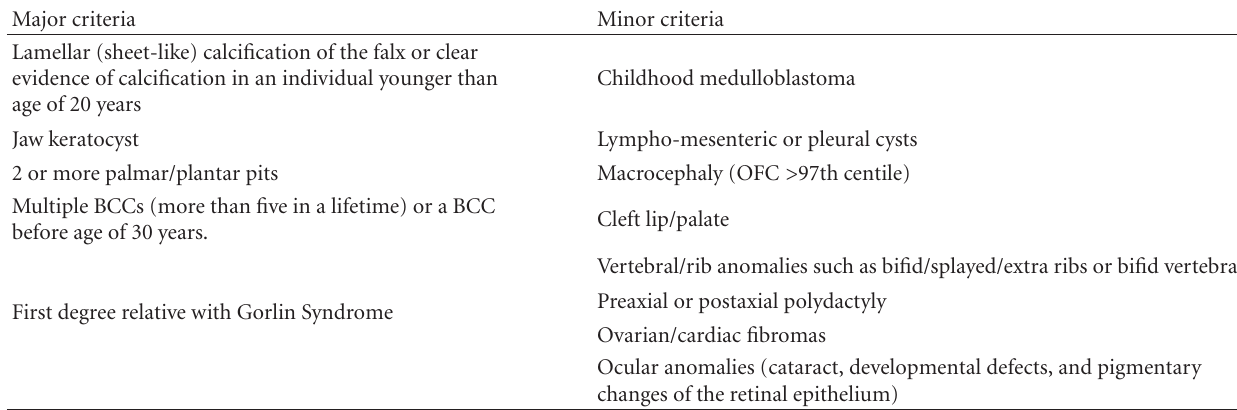
Table 1: Diagnostic criteria for Gorlin Syndrome. A diagnosis can be made when 2 major or 1 major and 2 minor criteria are fulfilled. Major